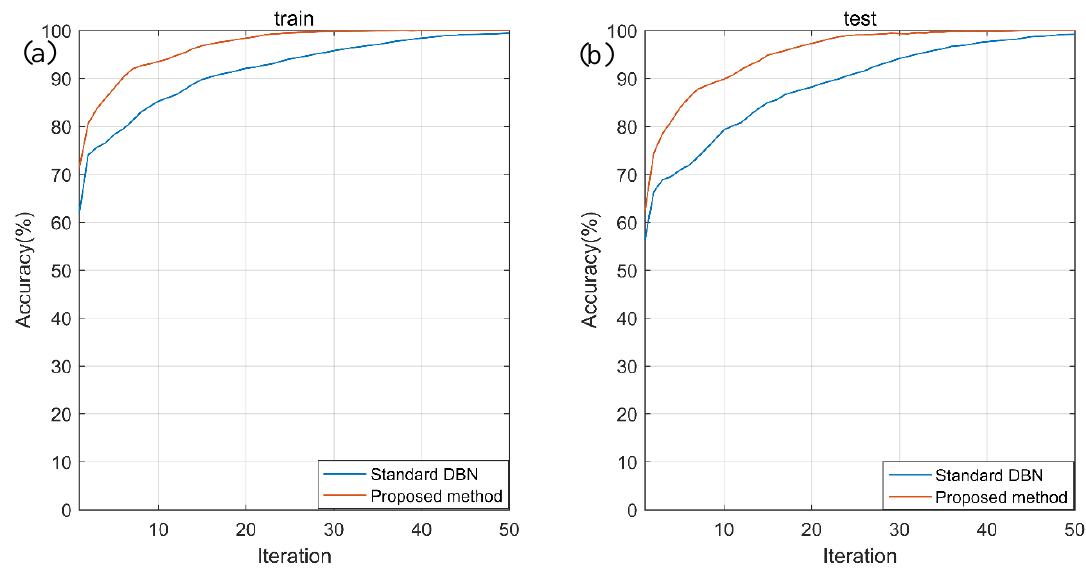
Figure 11. Accuracies’ trends of ( a ) training and ( b ) testing models for identifying fault type.